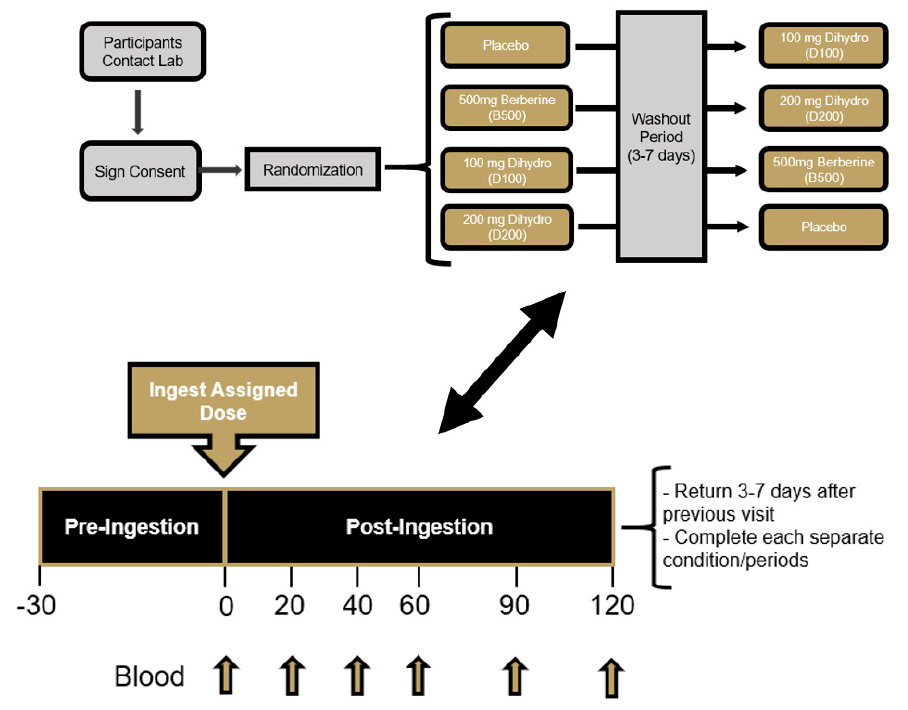
Figure 2. Overview of research design.